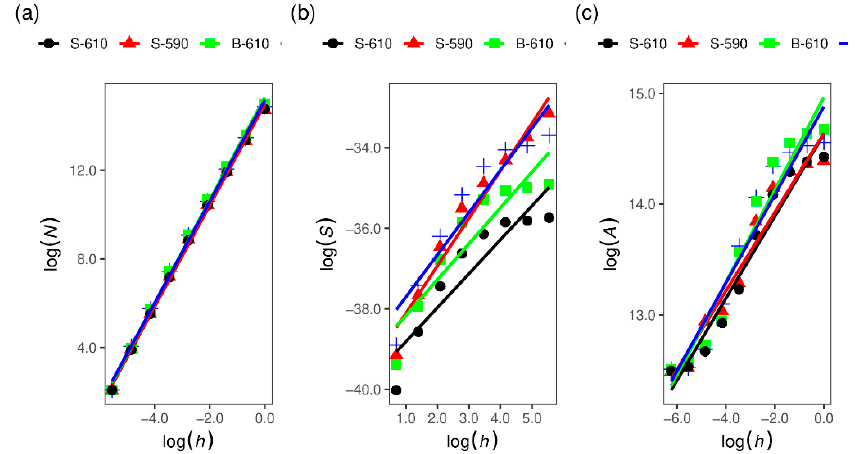
Figure 4. Fractal dimension calculation by: ( a ) cube counting method, ( b ) variance method and ( c ) triangulation method. Obtained values for fractal dimensions are summarised in Table 2.